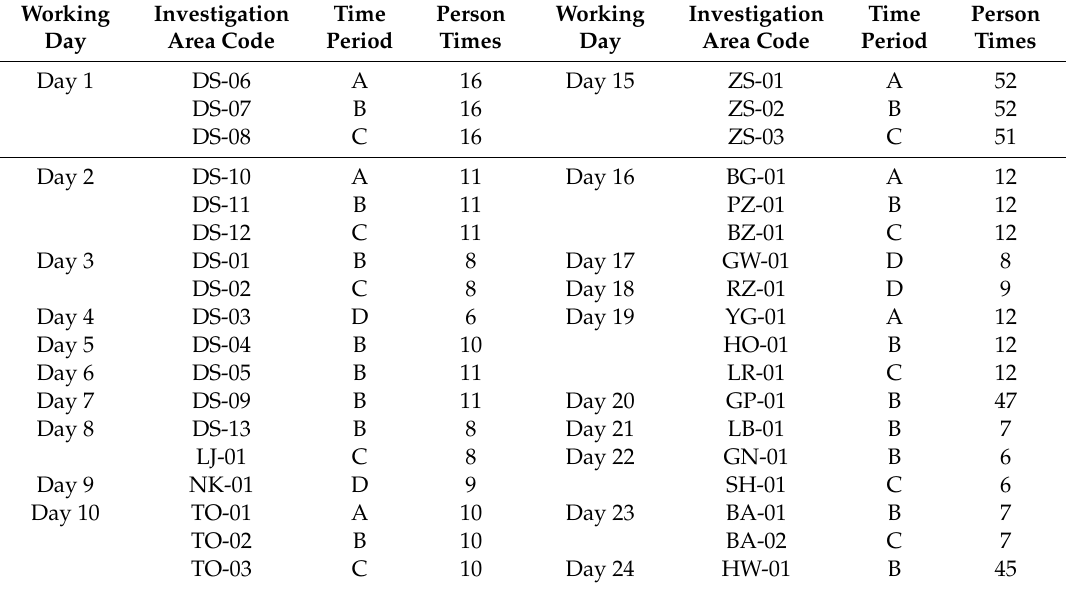
Table 2. Survey time and recording distribution detected from fact